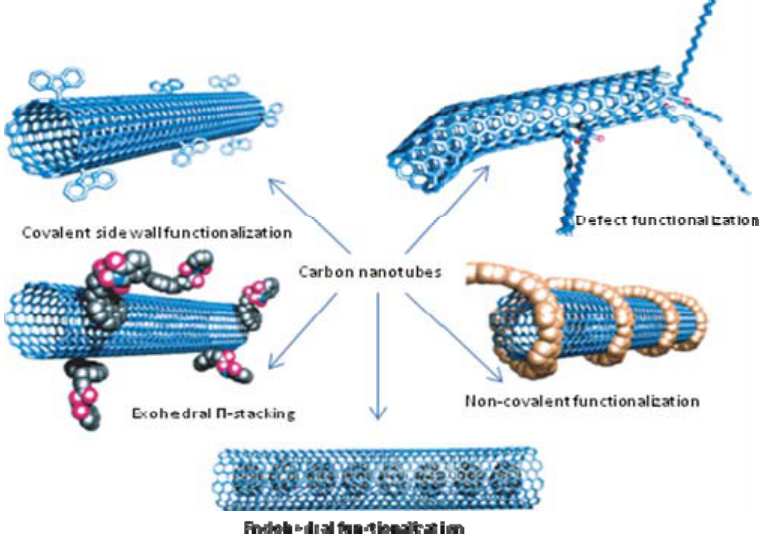
Figure 12. Functionalization methods. Adapted from reference 36, with permission